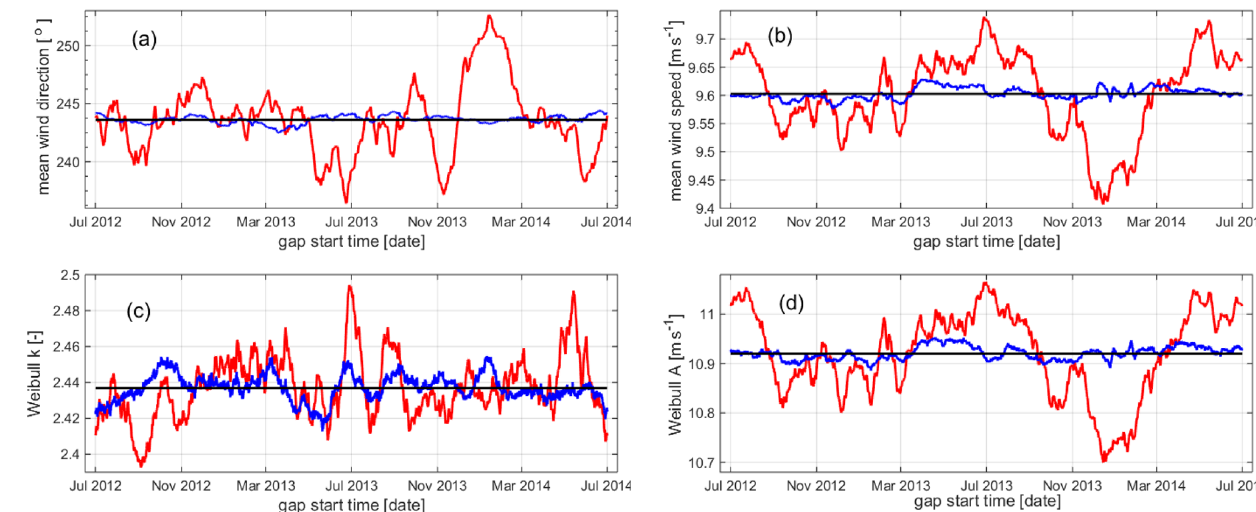
Figure 6. Variation in statistical measures – (a) mean wind direction and (b) mean wind speed and Weibull (c) shape and (d) scale parameters, k and A – depending on start date of artificial gap – here for a gap length of 30d, for incomplete time series in red and for filled time series in blue. Wind statistics for the original time series are in black as